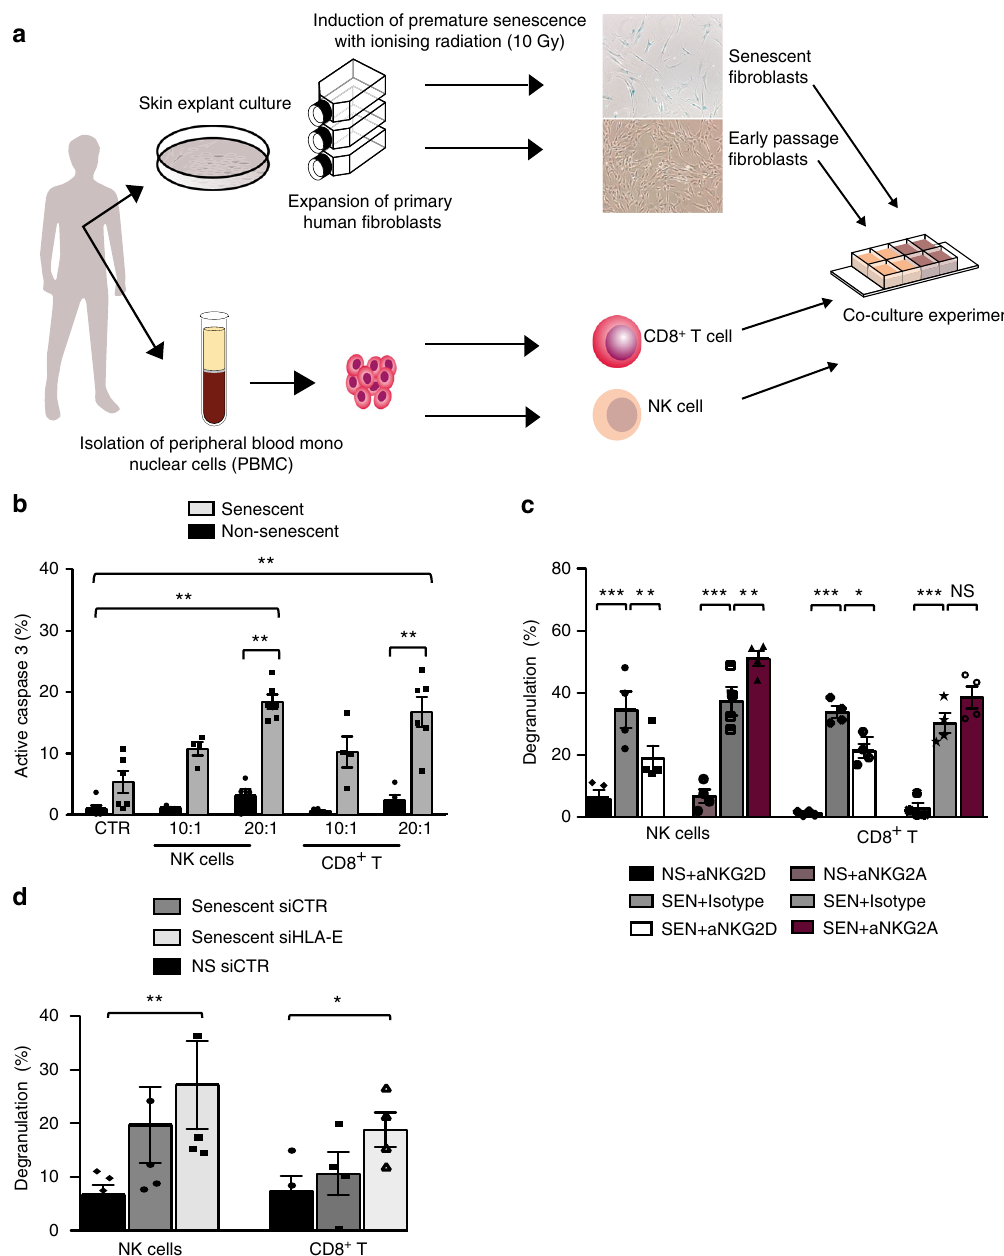
Fig. 4 HLA-E/NKG2A blockade enhances senescent cell killing. a The experimental design of the autologous co-culture system to study immune surveillance of senescent cells: primary human fi broblasts from the skin of healthy volunteers were expanded and induced to senescence by ionising radiation. NK and CD8 + T cells from peripheral blood of the same donors ( n = 5, age range 20 – 46) were used in co-culture experiments with autologous fi broblasts. b The summary data ( n = 6) of active caspase 3 expression by non-senescent (black) and senescent fi broblasts (grey) after incubation with NK cells or CD8 + T cells, using different effector to target (E:T) ratios. Controls (CTR) indicate spontaneous activation of caspase 3 in fi broblasts cultured without effector cells. c NK and CD8 + T cells were pre-incubated with blocking antibodies to NKG2A (Z199), NKG2D (1D11) or isotype-matched controls, using an E:T ratio of 20:1. The summary data ( n = 4) of degranulation of NK and CD8 + T cells towards senescent and non-senescent fi broblasts assessed by CD107a expression. d The cumulative data of CD107a expression in NK ( n = 5) and CD8 + T cells ( n = 4) after incubation with normal and senescent fi broblasts transfected with siRNA to HLA-E or a control siRNA. The data are presented as the index of degranulation (calculated as described in the Methods section) in c and d . Measurements were from distinct samples. Statistical analysis done with Mann – Whitney U test in ( b ) and one-way ANOVA with Bonferroni's multiple comparison test in c and d . The data presented as means ± SEM. * p < 0.05, ** p < 0.01, *** p < 0.001, **** p < cytotoxicity 38 , indicating that both NK and CD8 + T cells can isotype control (Fig. 4c). By contrast, pre-incubation with target senescent fi broblasts in vitro (Fig. 4c). Pre-incubation of NKG2A blocking antibody (Z199) signi fi cantly boosted the effector cells with NKG2D blocking antibody (1D11) decreased response of NK cells (Fig. 4c) and CD8 + T cells (Fig. 4c) against senescent cells, as compared with matched isotype controls. both NK and CD8 + T-cell degranulation towards senescent fi broblasts as compared with cells pretreated with a matched Collectively, these fi ndings indicate that both NK and CD8 +